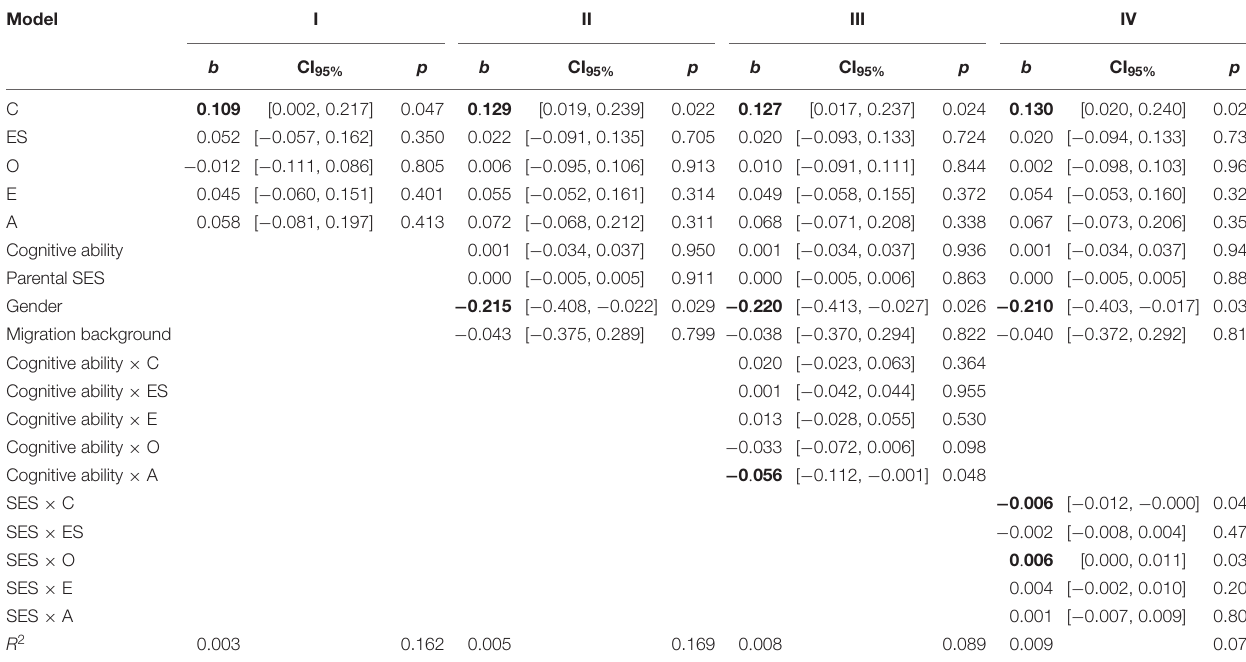
TABLE 4 | Unstandardized regression coefficients for the number of acceptances for VET positions within 1 year after graduation regressed on the Big Five and the covariates.